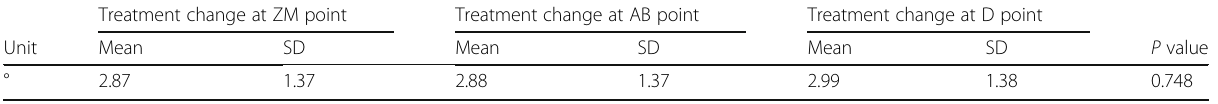
Table 4 Mean values of the total frontozygomatic, frontoalveolar, and frontodental angles Treatment change at ZM point Treatment change at AB point Treatment change at D